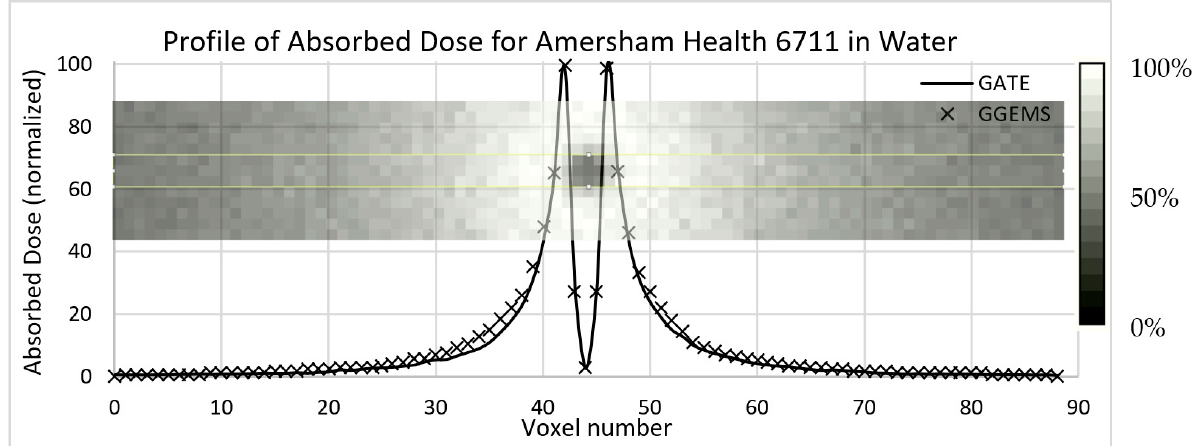
Figure 5. Profile of absorbed dose in water sphere (15 cm radius) of the Amersham Health 6711 Brachytherapy 125 I seed. The voxel size is 0.25 mm, and image dimensions are 89 × 13 × 89 voxels (this does not cover the whole water sphere). The seed is in the middle and oriented towards the inside of the paper.